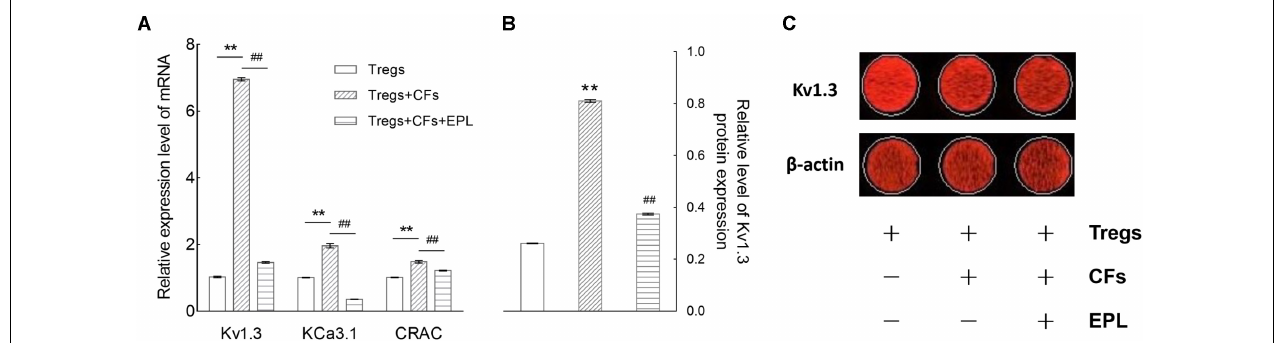
FIGURE 7 | Eplerenone antagonizes the augmentation of mRNA and protein expression of Kv1.3 channel (and/or other channels) by Tregs co-cultured with CFs. (A) After 48 h of co-culture, the mRNA expression levels (by RT-qPCR) of Kv1.3, KCa3.1, and CRAC (Ca 2 + release-activated Ca 2 + ) channels were enhanced by 6.76-, 1.94-, and 1.46- fold, respectively (Tregs + CFs vs. Tregs, n = 8, ∗∗ P < 0.01), whereas treatment with 30 µ M eplerenone suppressed these levels by 78.98, 81.68, and 17.93%, respectively (Tregs + CFs + EPL vs. Tregs + CFs, n = 8, ## P < 0.01). Accordingly, the protein expression of Kv1.3 channels were detected shown in (B) . The relative levels of Kv1.3 channel protein expression in the Tregs + CFs group were increased by 2.11-fold relative to the Tregs group ( n = 8, ∗∗ P < 0.01), and 30 µ M eplerenone suppressed these elevated protein expression levels by 52.85% (Tregs + CFs + EPL vs. Tregs + CFs, n = 8, ## P < 0.01). (C) Original images of Kv1.3 channel protein detecting by In-Cell Western Blotting.